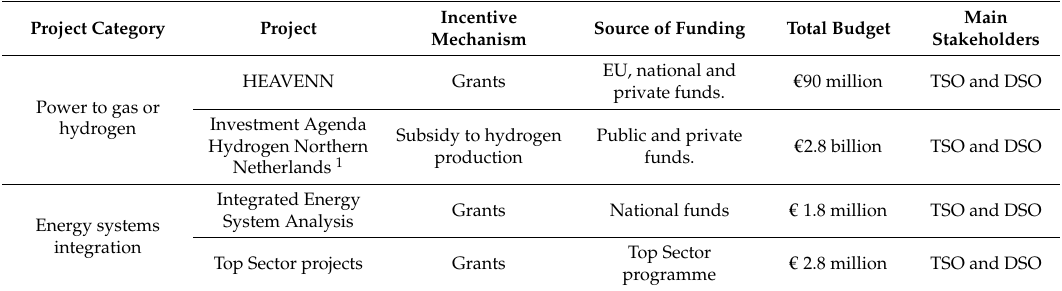
Table 6. Overview of network innovation projects in the